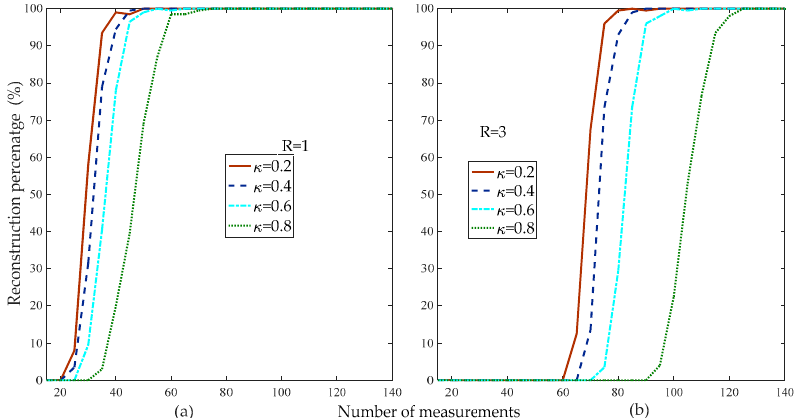
Figure 10. Reconstruction percentage of the proposed method with different weak selection thresholds ( d = 100, R = 1,3, κ = 0.2,0.4,0.6,0.8, m = 15 : 5 : 140, random low rank